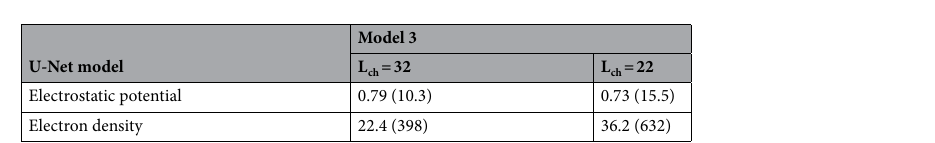
Figure 8. Comparisons of electrostatic potential and electron density between U-Net (upper) and TCAD (lower) for L ch = 32 ( a,b ) and 22 ( c,d ) nm.